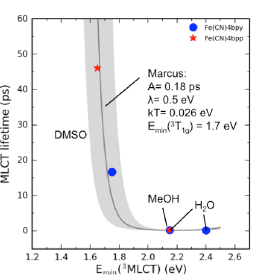
Fig. 3. MLCT lifetime dependence on 3 MLCT energy. Shaded area corresponds to +/-0.1 eV shift of the Marcus